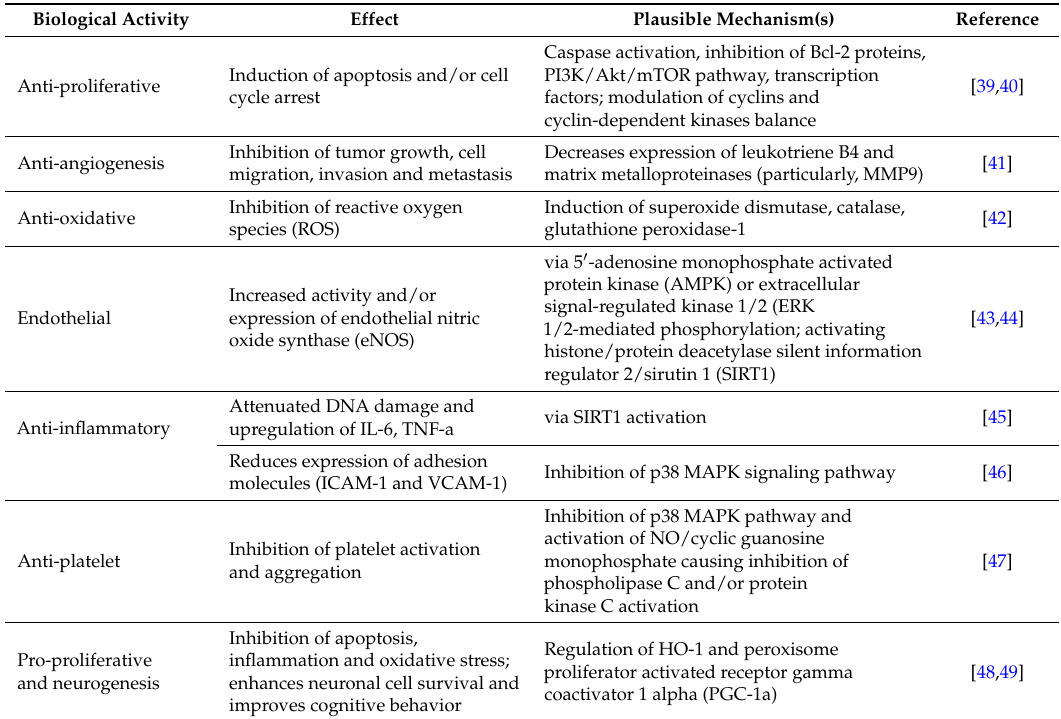
Table 2. Some of the main biological activity, their effects and plausible mechanisms of action of resveratrol as demonstrated in different in vitro and in vivo